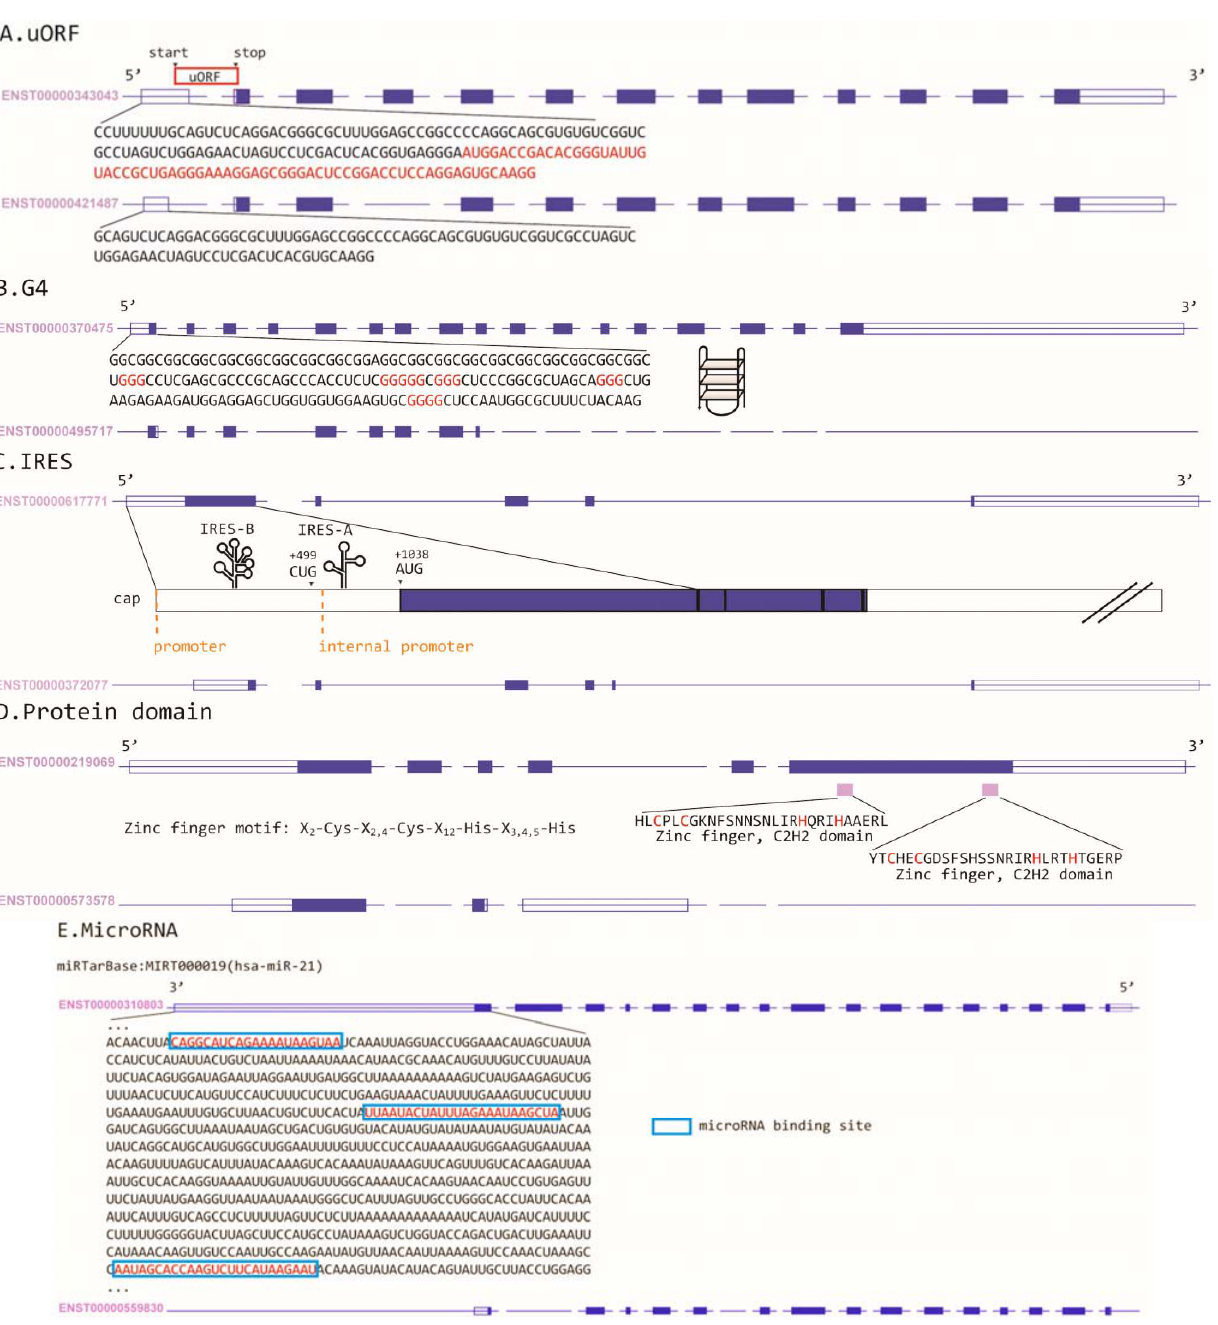
Figure 1. Alternative RNA structure-regulated presence/absence of ( A ) upstream open reading frame (uORF); ( B ) G-quadruplex (G4); ( C ) internal ribosomal entry sites (IRES); ( D ) protein domain (zinc finger domain in this example); and ( E ) microRNA binding site. The empty boxes and the blue boxes, respectively, represent UTR exons and coding